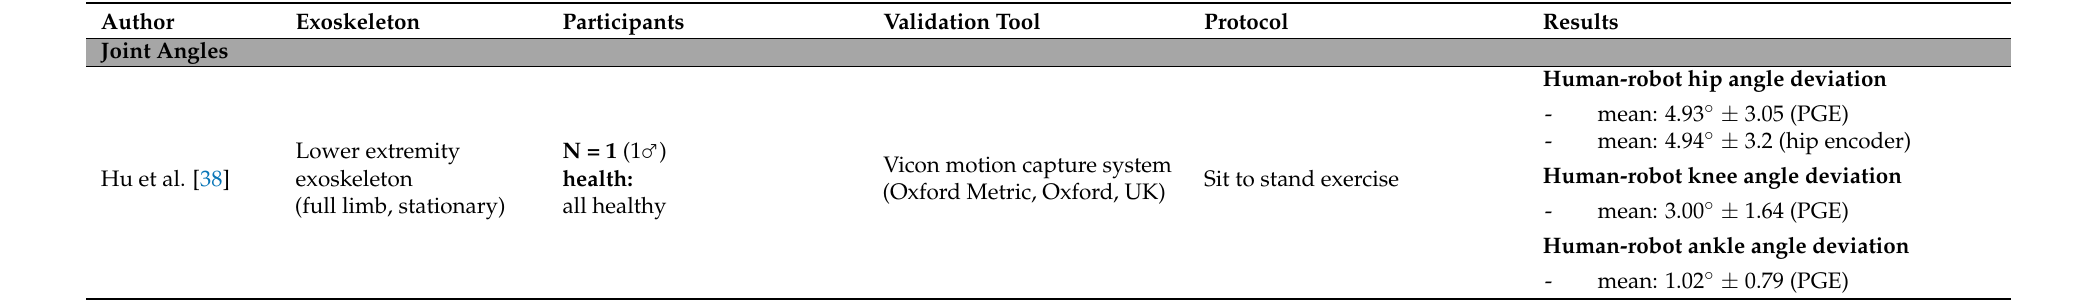
Table 2. Overview and results of validity and reliability studies (Abbreviations: 6MWT, 6-min walk test; BM, baseline model; CP, cerebral palsy; DEP,